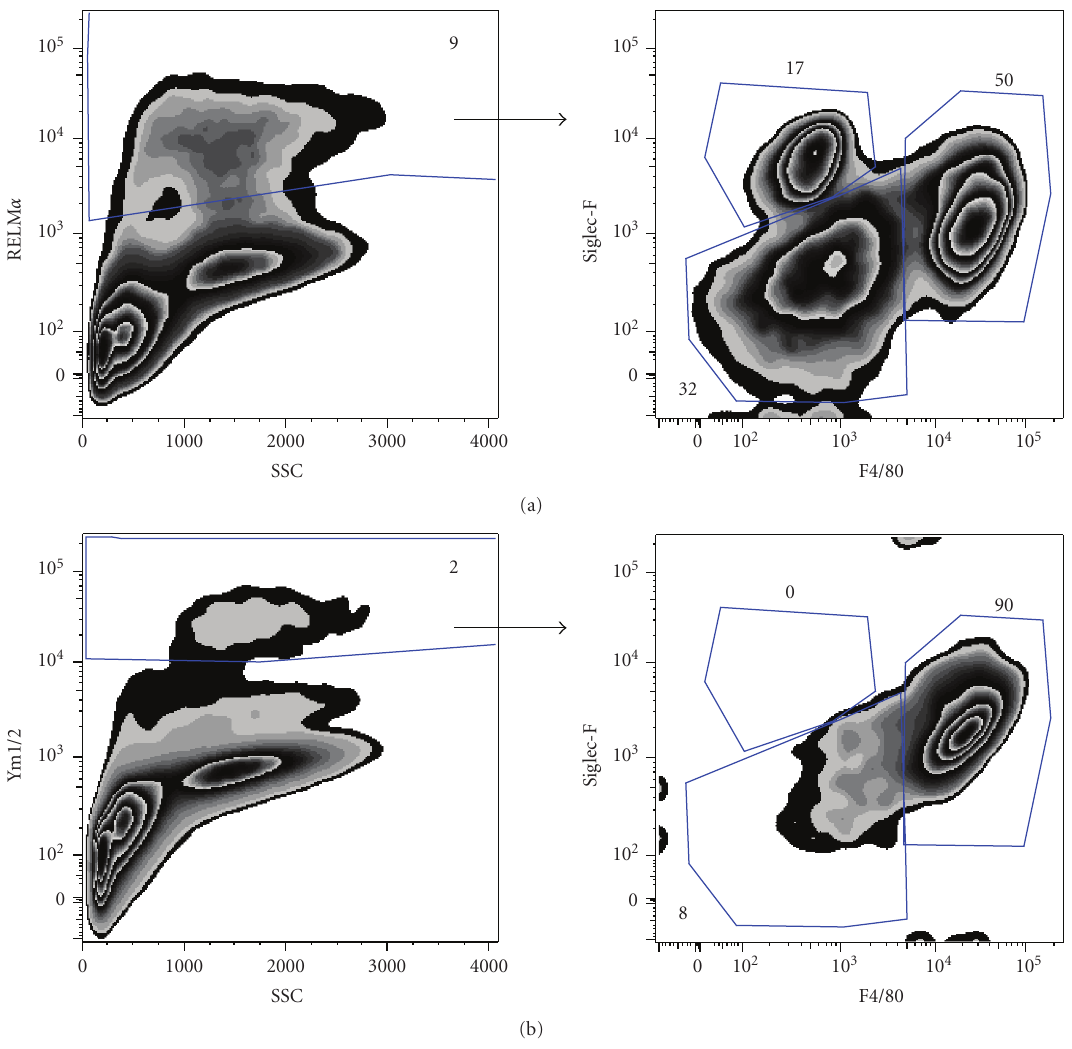
Figure 1: RELM α and YM1/2 expression in the pleural cavity during L. sigmondontis infection. Left-hand plots: Flow cytograms depicting side scatter (SSC) versus RELM α (a) or Ym1/2 (b) of pleural cavity cells 12 days post infection with L. sigmodontis . The gates for RELM α + and Ym1/2 + cells were set using isotype control staining. The proportion of cells positive for RELM α and Ym1/2 in na¨ıve mice was 1.5% and 0.05%, respectively. Right-hand plots: Siglec-F versus F4/80 expression on Ym1/2 + or RELM α + cells. Numbers in italics represent percentage of cells within the neighbouring